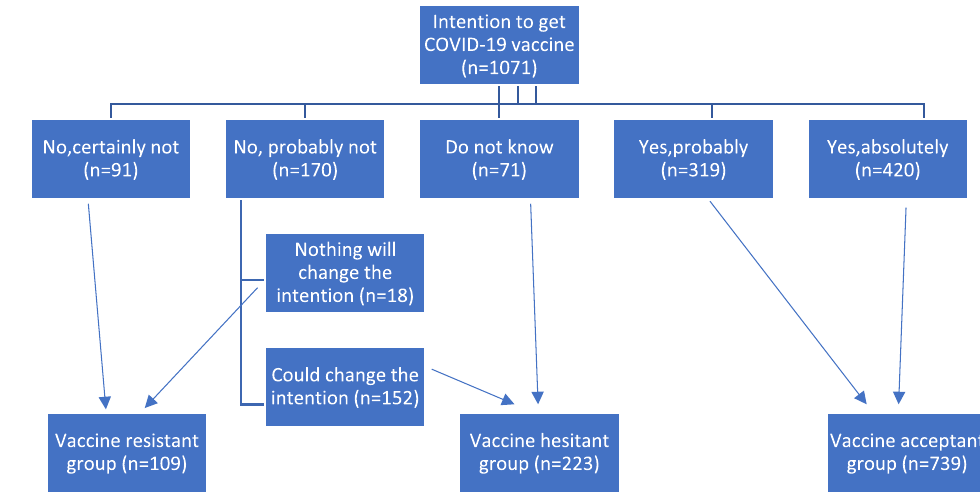
Fig. 1 Flowchart of the study groups according to COVID-19 vaccination